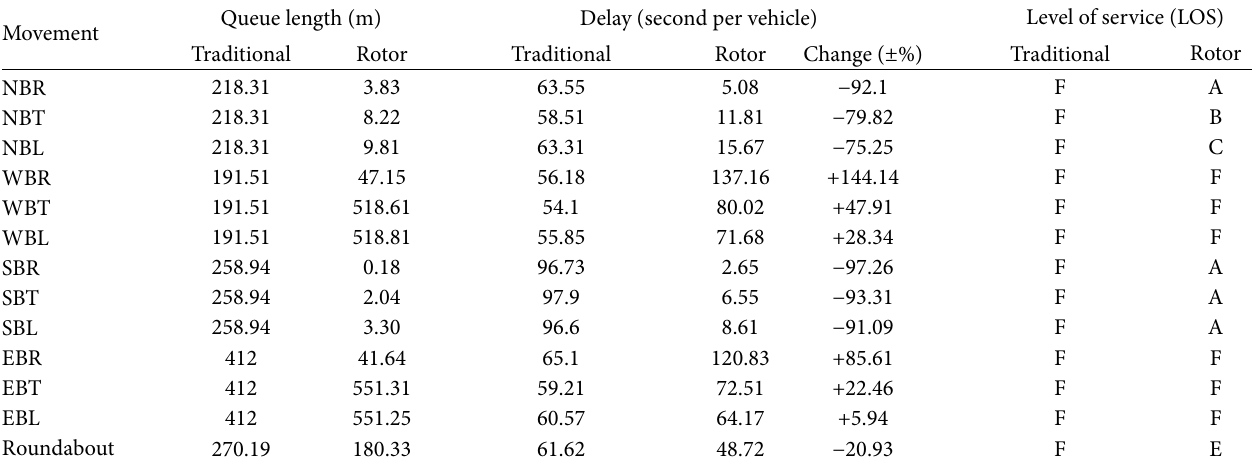
Table 7: Queue length, vehicle delay, and LOS (alternative design 1).